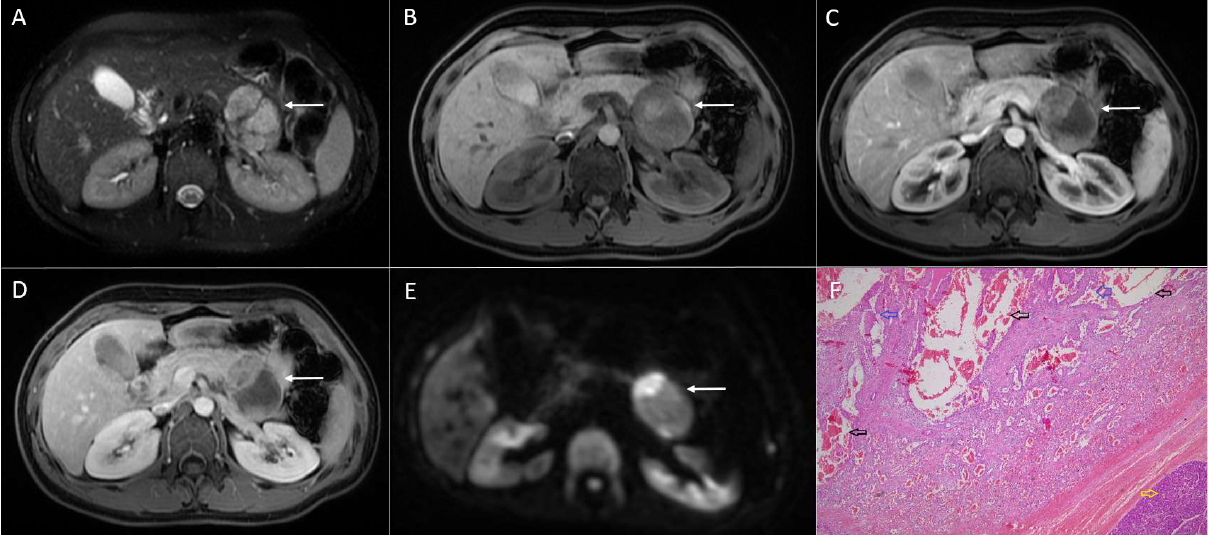
Figure 2. Solid pseudopapillary neoplasm of the pancreas in 33-year-old woman. Well-demarcated heterogeneously hyperintense lesion ( arrow ) on T2-weighted FS image ( A ) located in the pancreatic tail is shown. On native T1-weighted FS image ( B ), the lesion ( arrow ) is mainly hypointense with small hyperintense areas indicating hemorrhage, showing only discrete enhancement of the solid component in arterial phase ( C ), and slow progressive enhancement in portal-venous phase ( D ). On DWI, solid part of the lesion shows restricted diffusion ( E ). Hematoxylin and eosin (H&E) staining ( F ) showed microcystic areas ( black arrows ), with pseudopapillary structures inside of them ( blue arrows ), and normal pancreatic parenchyma next to the tumor ( yellow arrow ); original magnification ×400.